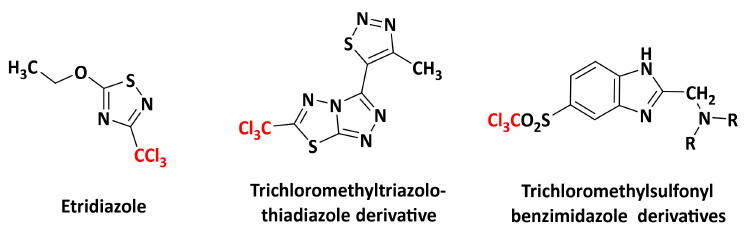
Figure 3. Structures of some trichloromethylated derivatives as